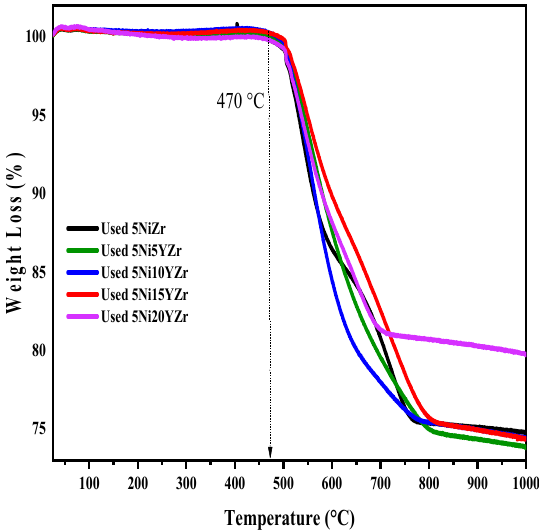
Figure 6. TGA profile for all spent catalysts at a reaction temperature of 700 °C.